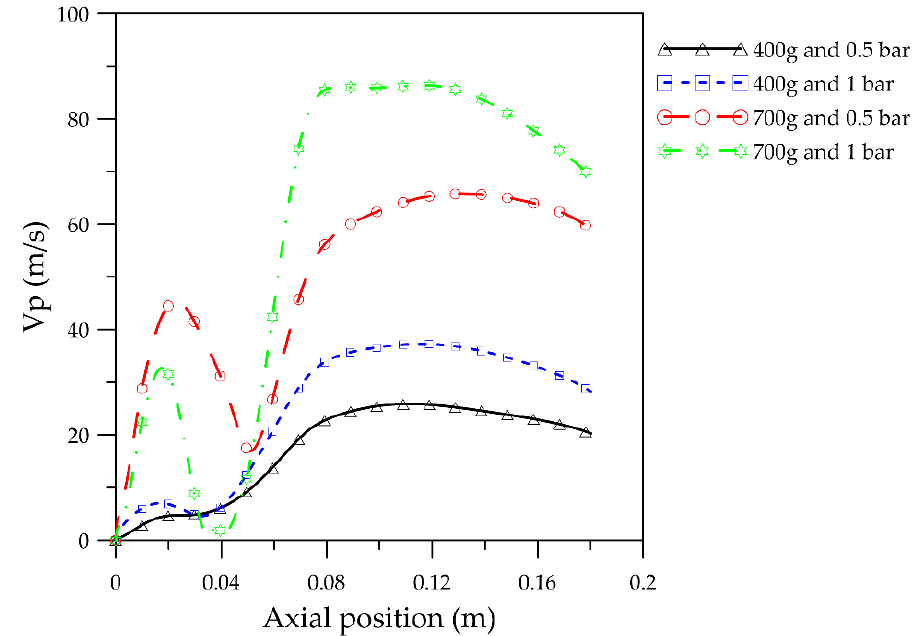
Figure 13. Axial distribution of the time-averaged particle velocity at the center of the equipment, from the bottom nozzle to the lower wall of the classifier.